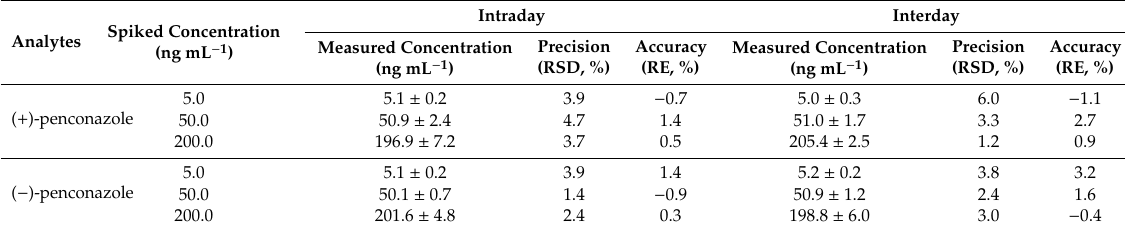
Table 2. Intraday and interday accuracy and precision of analysis method in spiked rat plasma at three quality control (QC) levels ( n = 6).